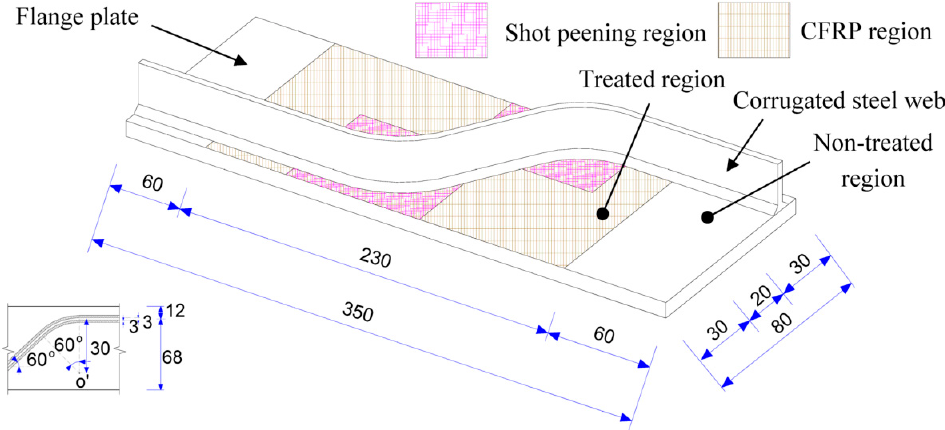
Figure 14. Geometry of a typical test specimen [234] (this is an open access article distributed under the Creative Commons Attribution License which permits unrestricted use, distribution, and re ‐ production in any medium, provided the original work is properly cited).